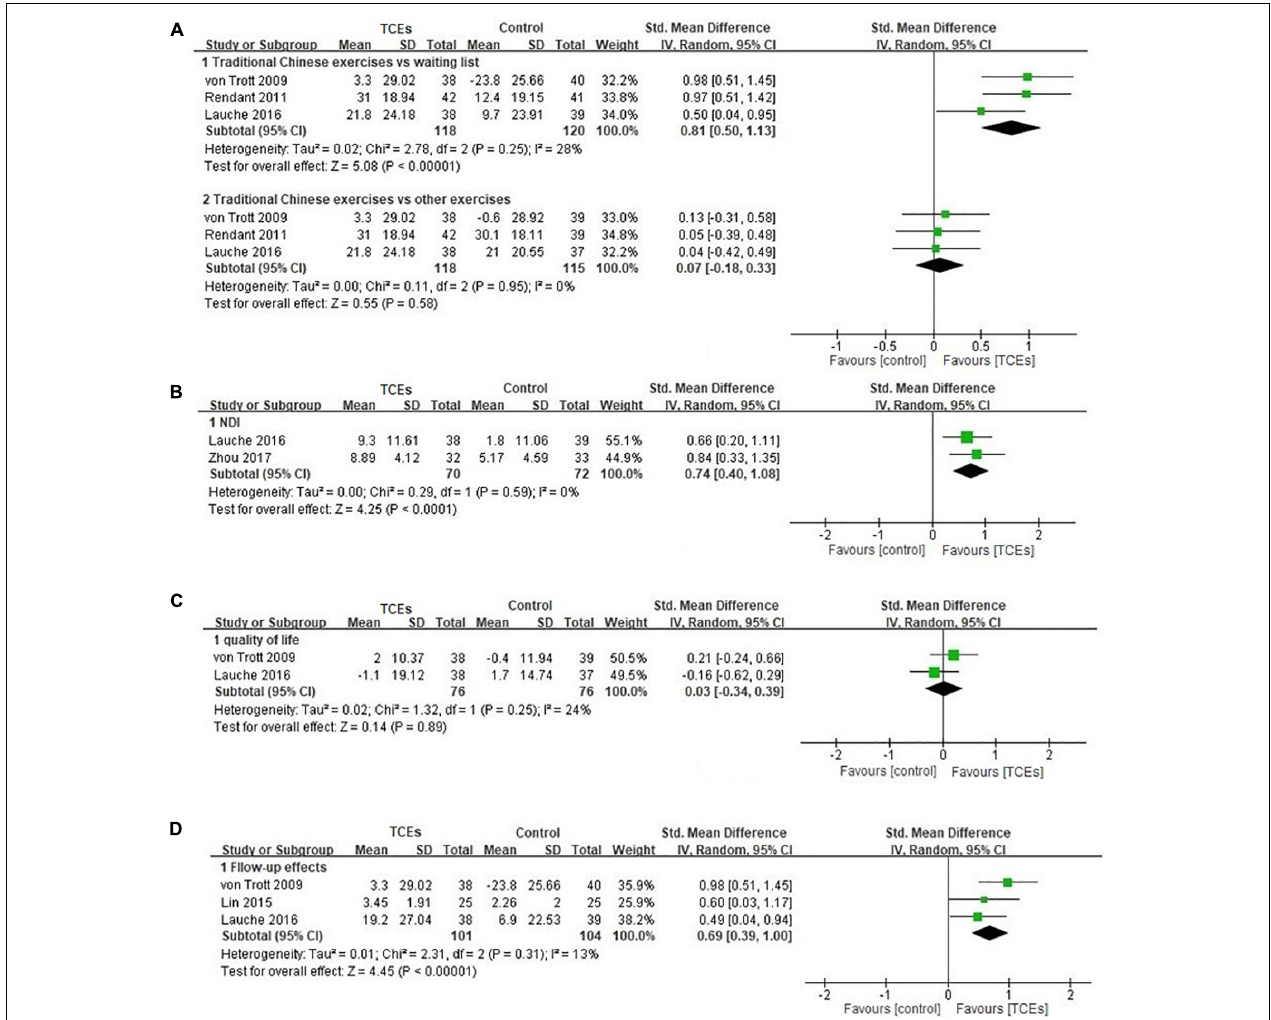
FIGURE 3 | Forest plot of the effects of traditional Chinese exercises (TCEs) alone for neck pain: (A) Pain, (B) neck disability index (NDI), (C) quality of life, and (D) follow-up effects on